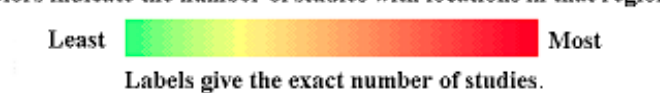
Figure 3. Geographic distribution of interventional trials (green low–red high). The trials distribution based on starting year is presented in Figure 4. The majority of the interventional trials (75%) had a randomized allocation design (Figure 5).